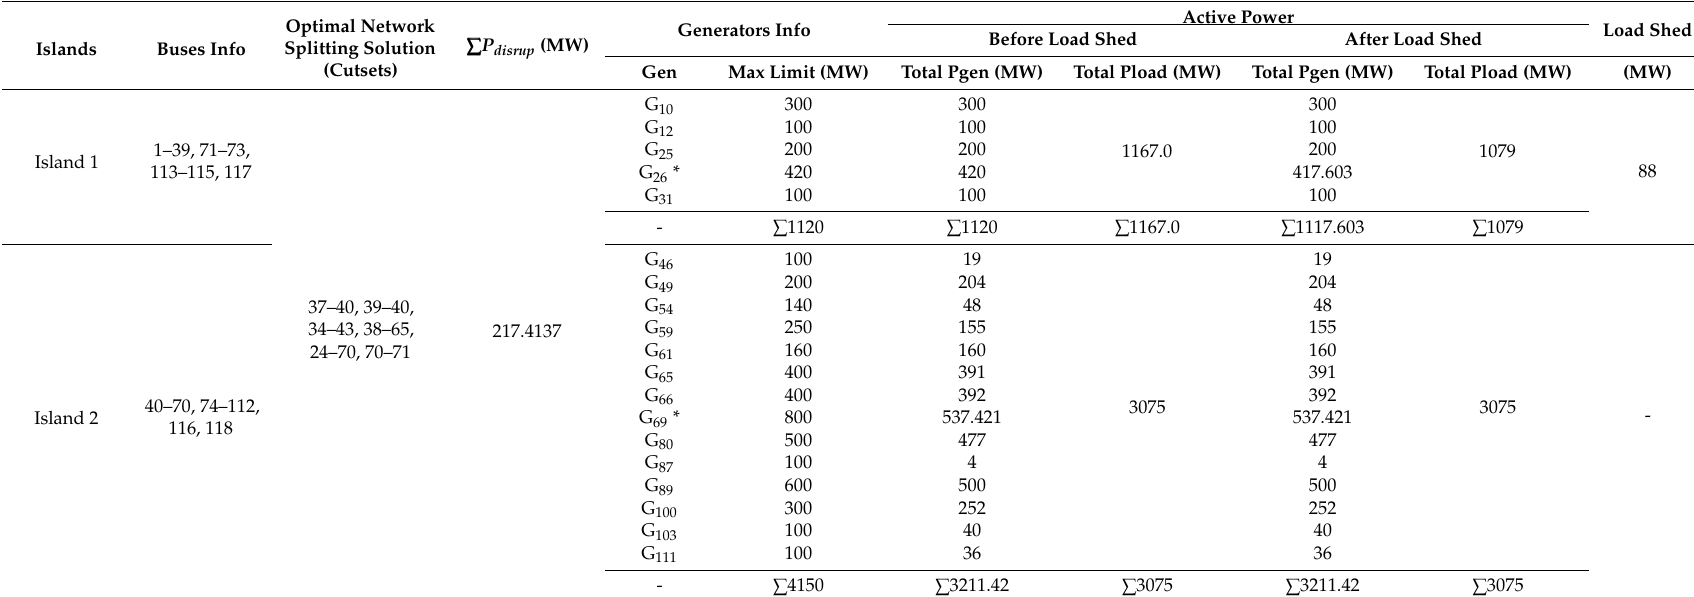
Table 1. IEEE 118 data after network splitting for Case